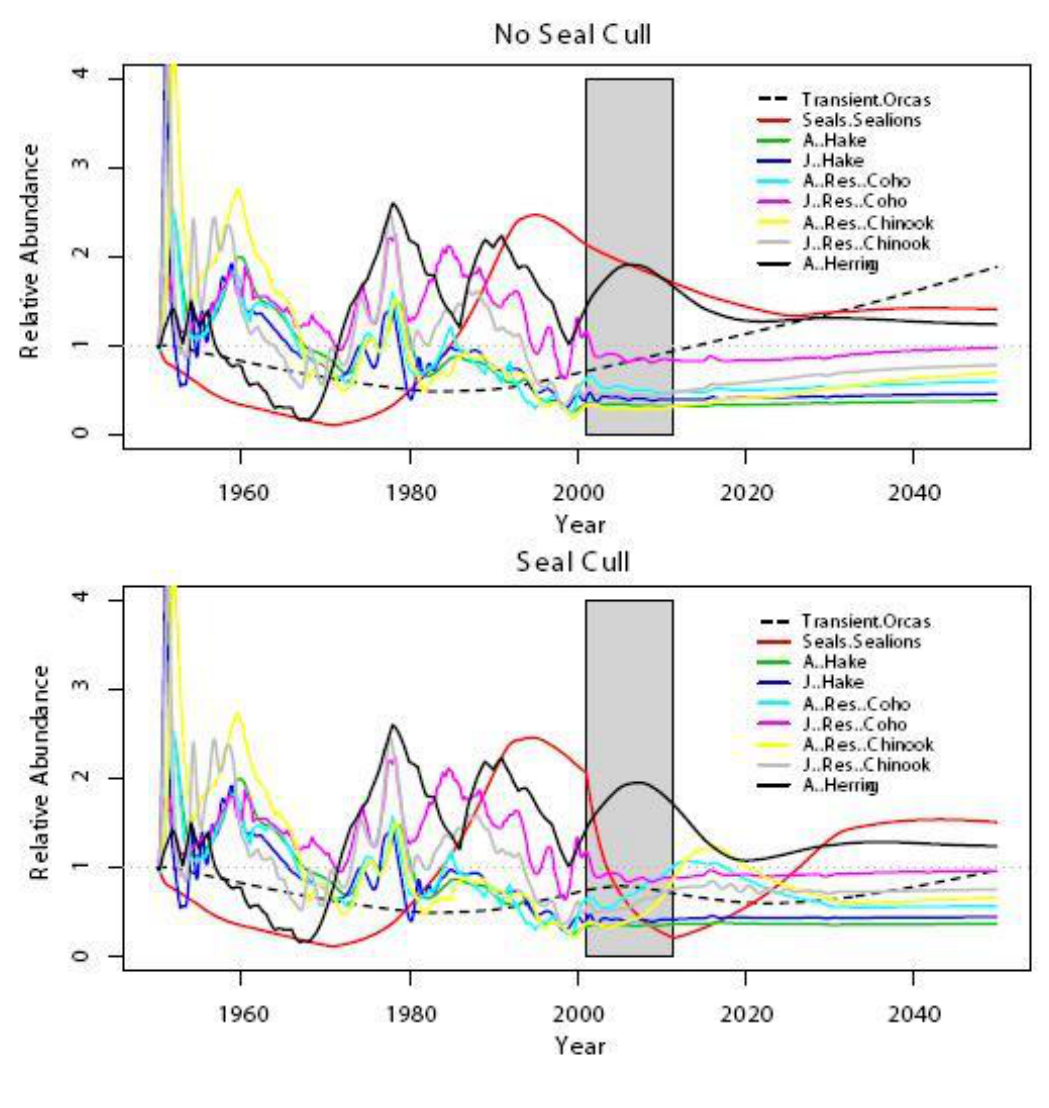
Fig. 3. Components of the Strait of Georgia ecosystem model in response to a 10-year seal cull (represented by the shaded region). An increase in abundance of transient orcas eventually reduces harbor seal abundance, and coho and chinook salmon abundance stabilizes at levels below historical average (top panel). Under a 90% reduction in harbor seals, transient orcas do not respond numerically, allowing harbor seal abundance to increase after the cull. Chinook and coho populations increase during the cull. However, the reduction in predation mortality is short lived, and abundance declines after the seal